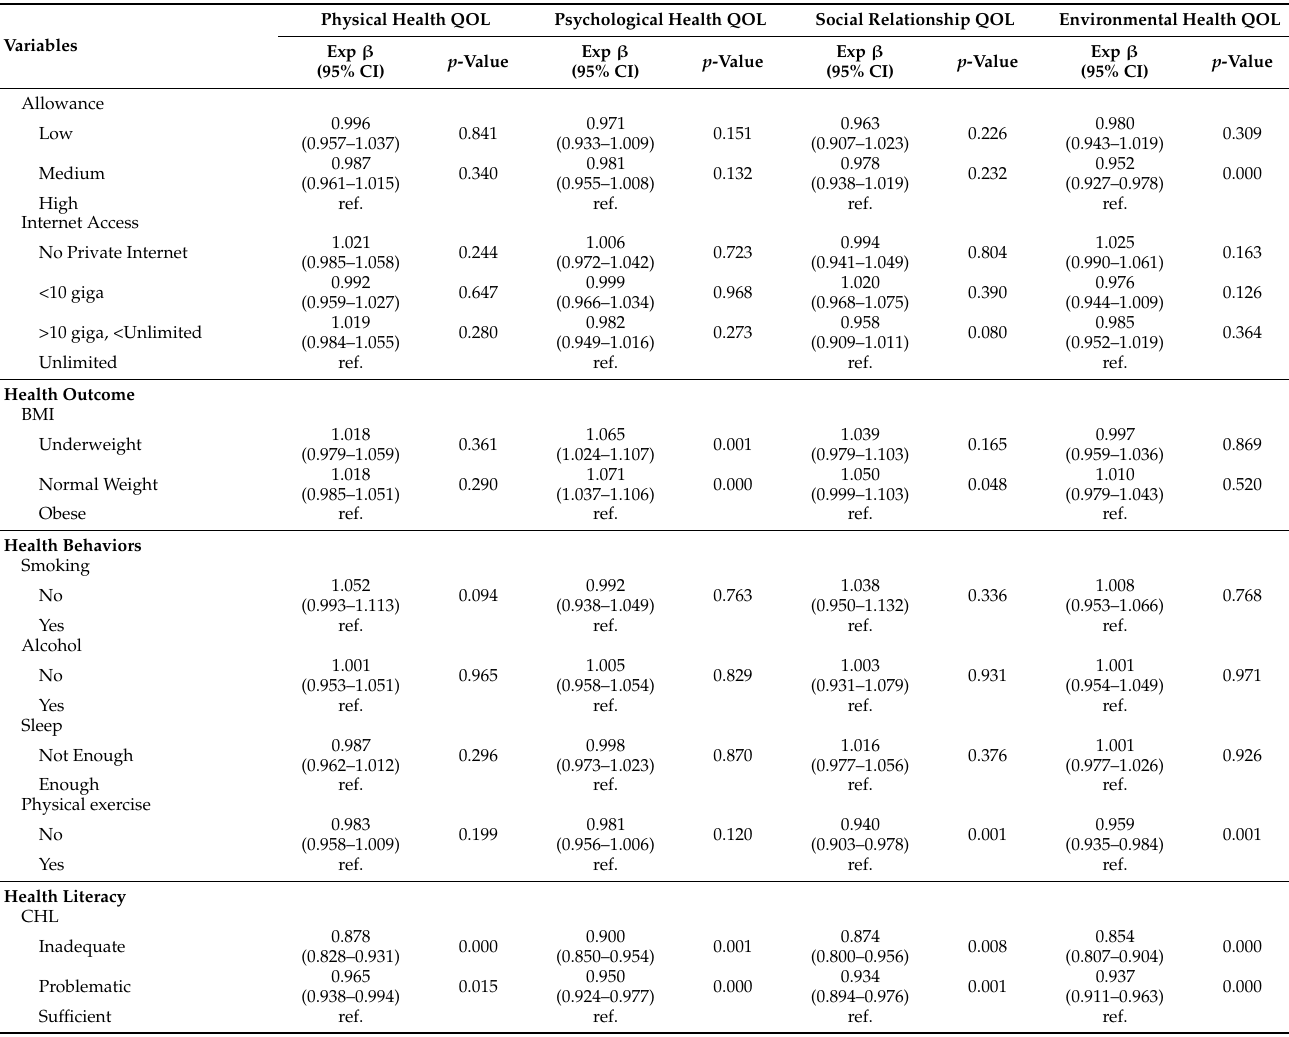
3.4. Multivariate Generalized Linear Models of the Four Domains of QOL with Socioeconomic Determinants, HBs, BMI, and